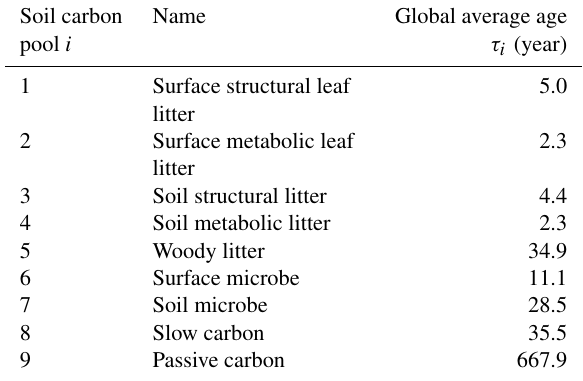
Table 2. Global average ages of soil carbon pools computed by BEPS with consideration of the influences of temperature and soil moisture on the decomposition rates of these